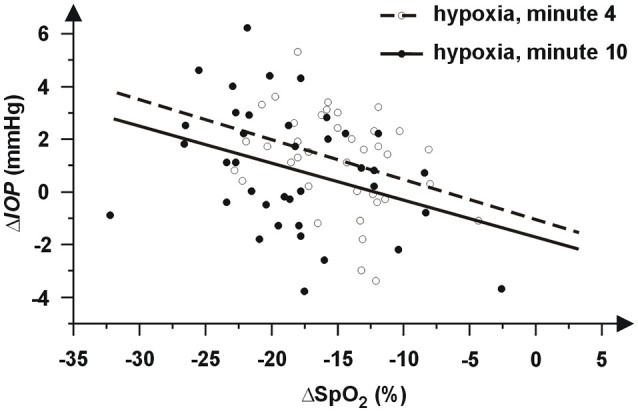
Graphic dependence of individual differences ΔIOP from its baseline IOPr on changes of peripheral capillary oxygen saturation (ΔSpO2) at minute 4 (open circles) and minute 10 (closed circles). The negative values represent a decrease. The dependences are approximated by regression lines (dashed line at minute 4 and solid line at minute 10).